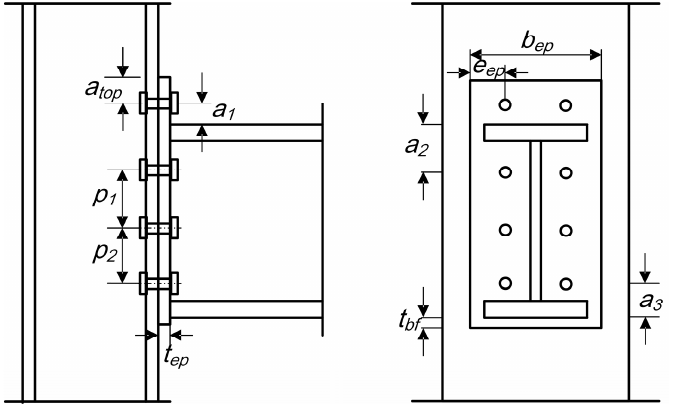
Figure 11. The layout of extended end-plate connection.